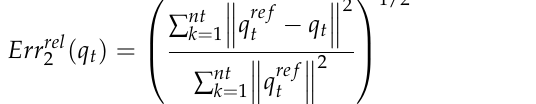
( U c ) and Err rel ( Y c ) according to grid, obtained 2 2